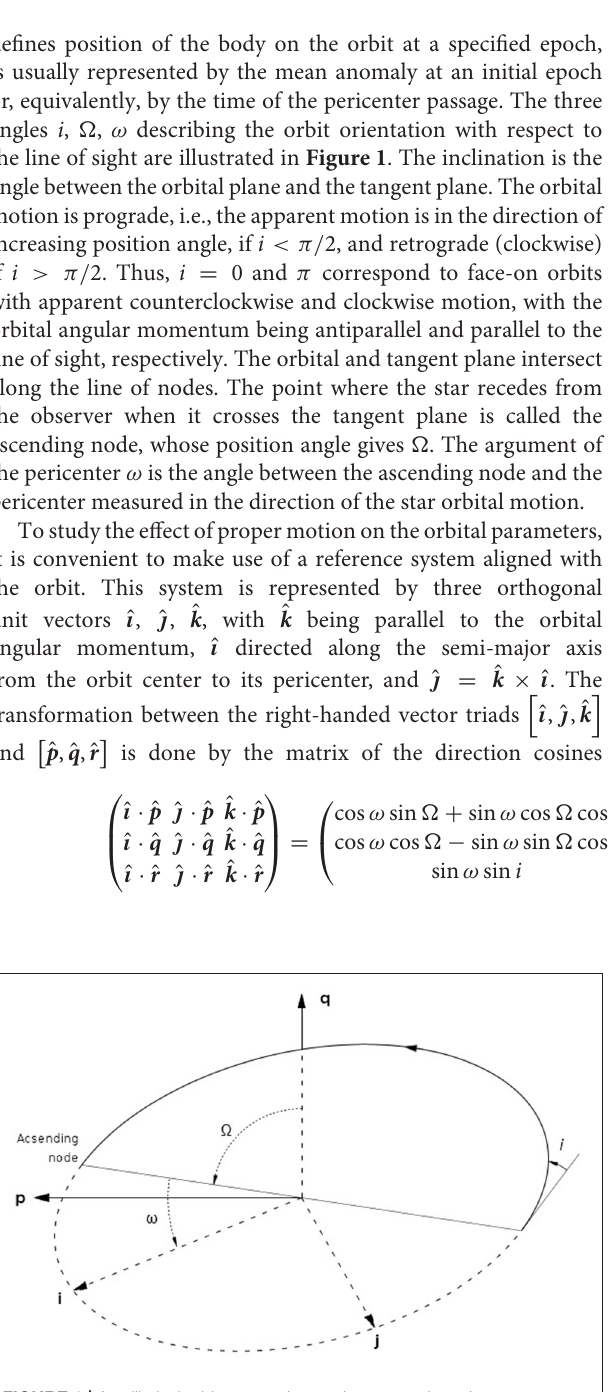
FIGURE 1 | An elliptical orbit as seen by an observer at the solar system barycenter, with the plane of the plot tangent to the celestial sphere. The unit vectors ˆ p and ˆ q specify the local directions of increasing equatorial coordinates α and δ . The arrow indicates direction of the orbital motion. i is the inclination of the orbit. The orbit crosses the tangent plane in the two nodes. The ascending node is the node where the object recedes from the observer. The position angle of the ascending node (cid:127) is reckoned counterclockwise from ˆ q in the tangent plane. The argument of the pericenter ω is the angle between the ascending node and the pericenter measured in the direction of the orbital motion. The orthogonal unit vectors ˆ i and ˆ j , with ˆ i pointing to the pericenter, define the Cartesian